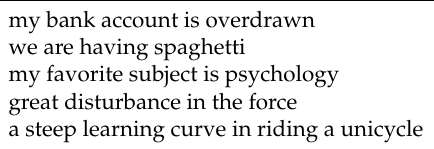
Table 1. Five examples of target phrases for assessing the ambiguous keyboard